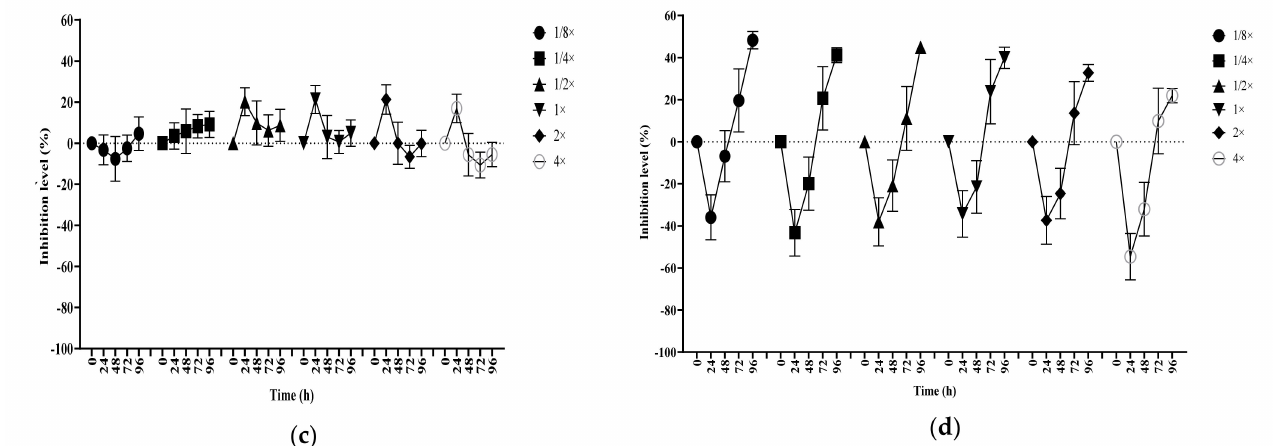
Figure 2. R. subcapitata index effect by the exposure to 4 different pharmaceuticals. ( a ) Atenolol; ( b ) Caffeine; ( c ) Carba- mazepine; ( d ) Ibuprofen. * See Table 1 for explanation of drug concentration linked to the sample